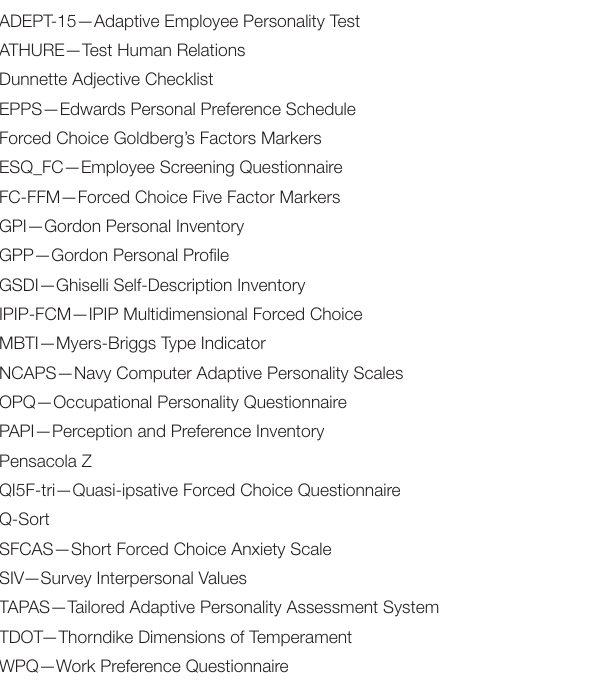
TABLE 1 | Forced-choice personality inventories included in the